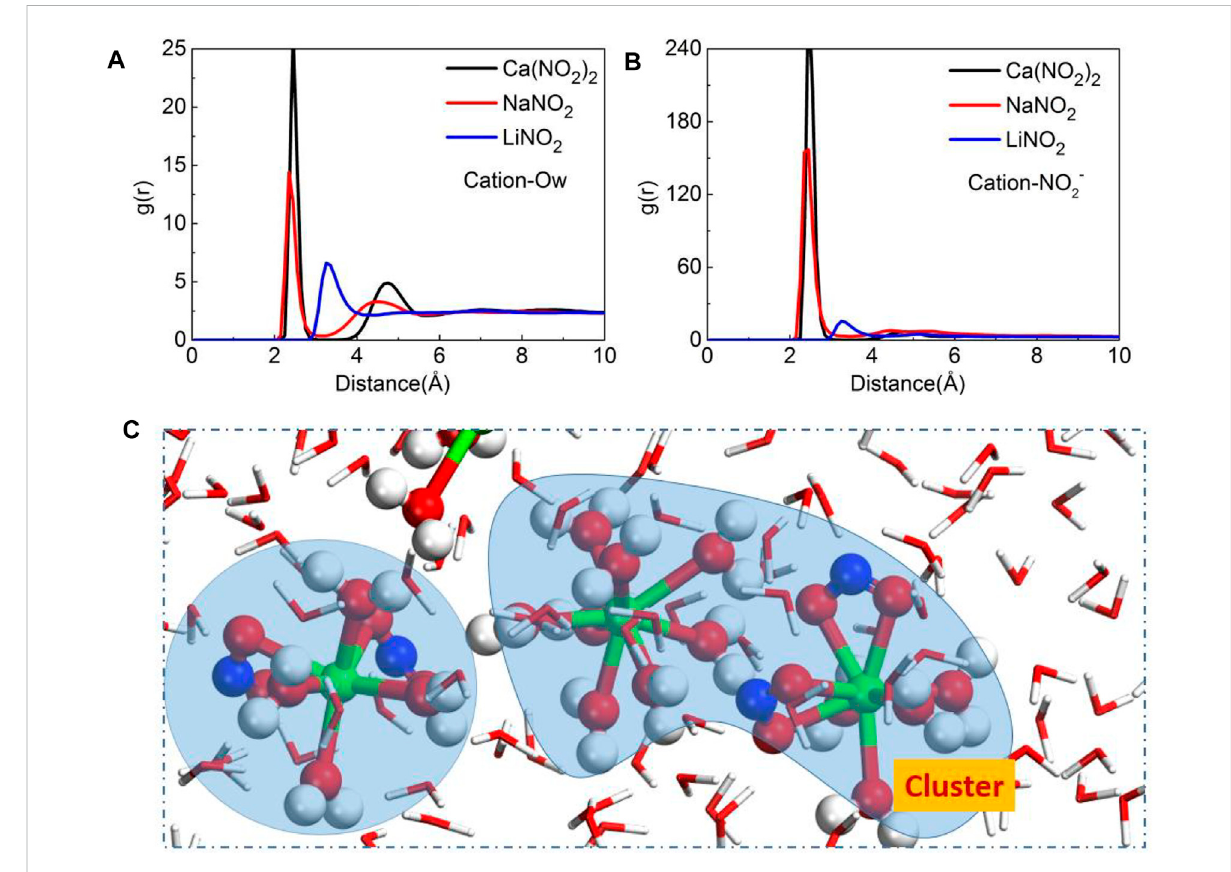
FIGURE 7 The radial distribution function (RDF) of (A) Cation-O w , (B) Cation-NO 2 − , (C) the ion clusters of the Ca(NO 2 ) 2